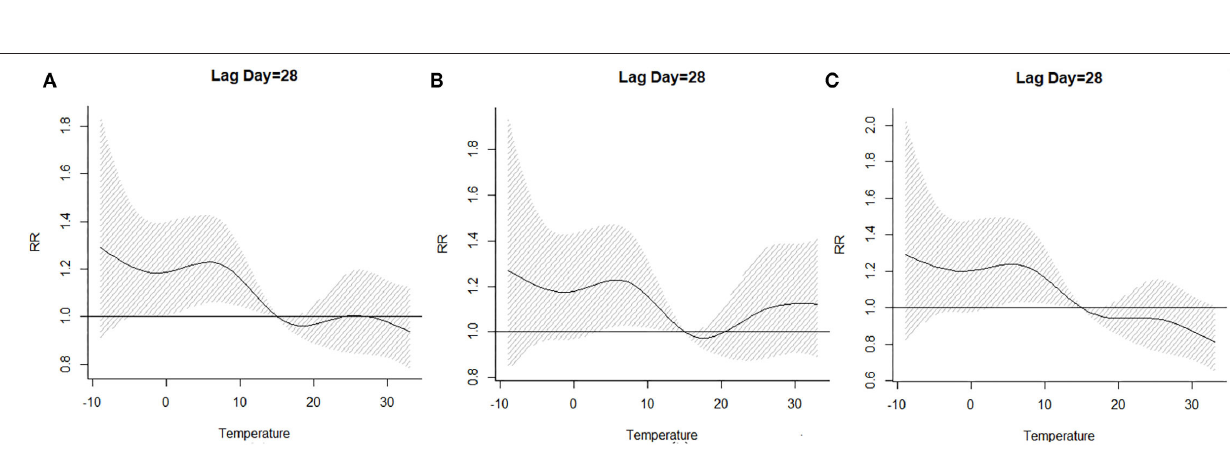
FIGURE 3 | Three-dimensional lag–response curve of temperature [ (A) whole; (B) men; (C) women]. RR, relative risk.